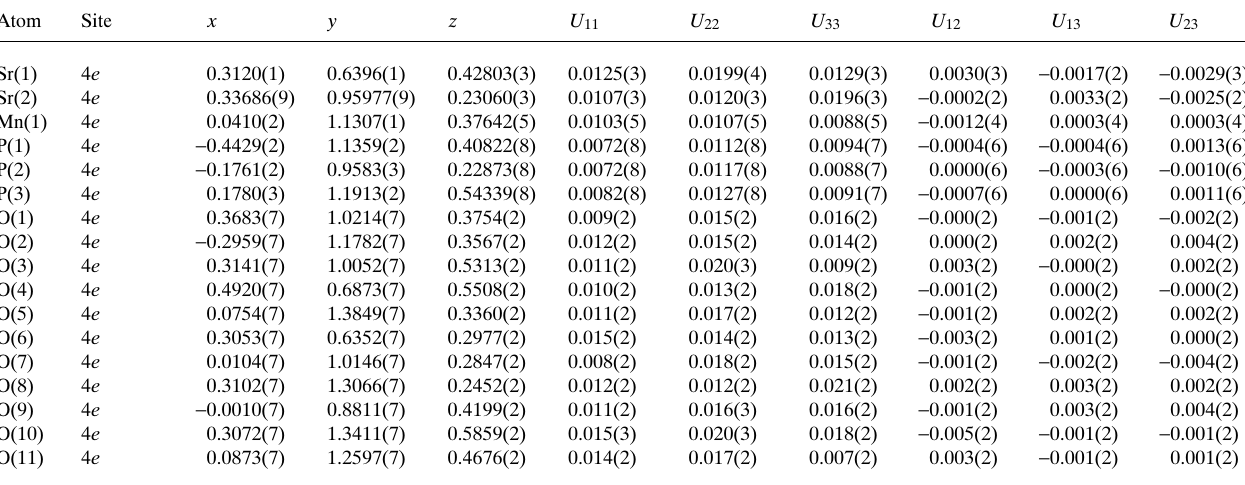
Table 2. Atomic coordinates and displacement parameters (in Å 2 )